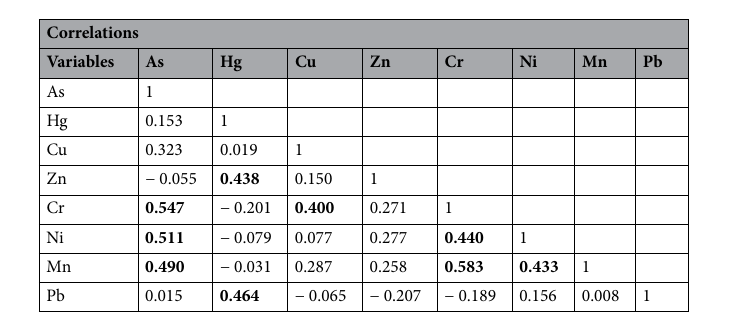
Table 7. Pearson correlation analysis among the heavy metals. Significant values are in